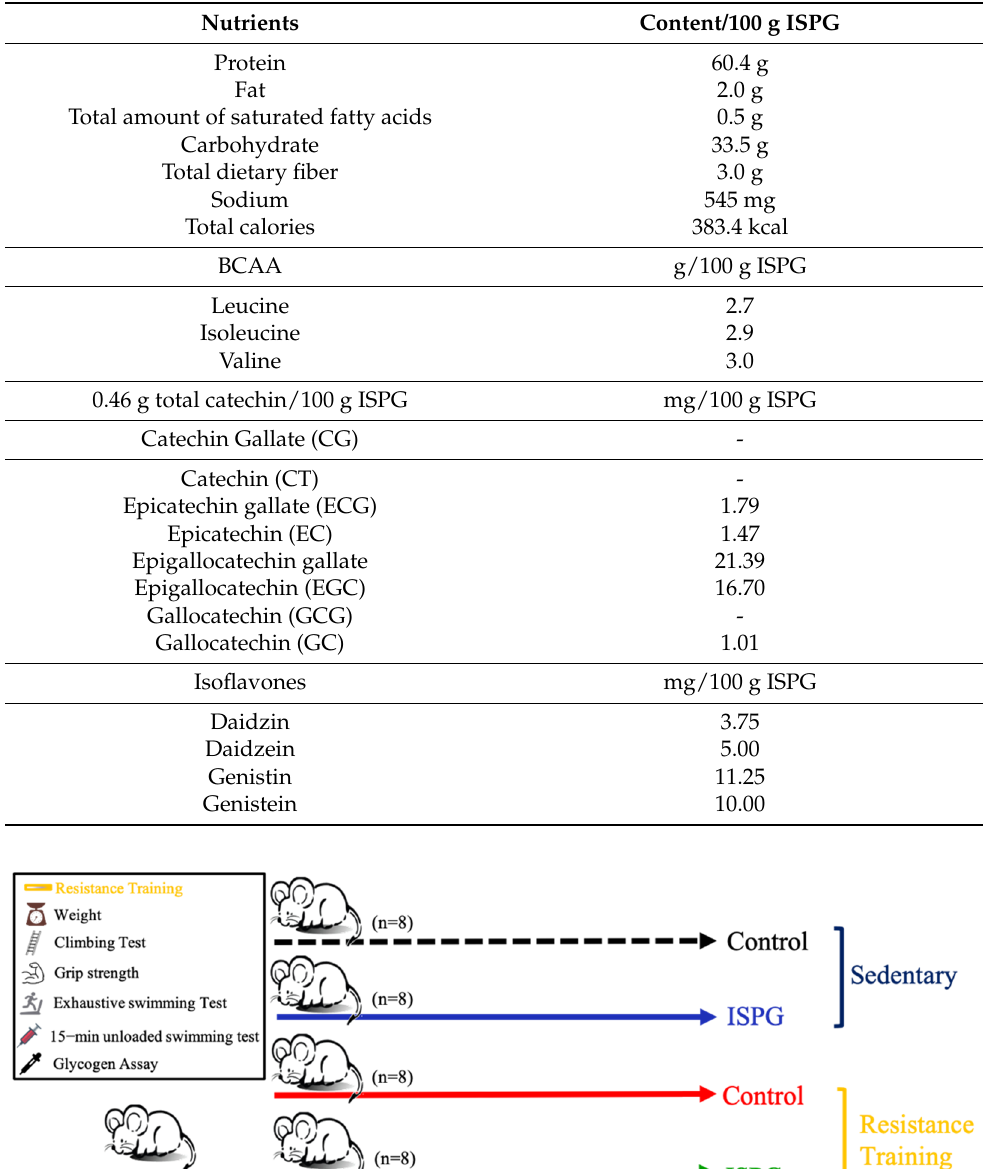
Table 1. Nutrients, hydrolyzed catechin and isoflavones of ISPG.